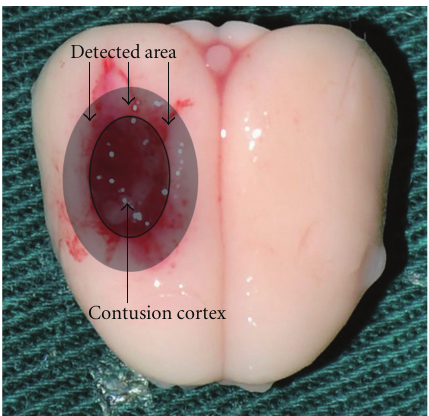
Figure 1: Schematic representation of the contusion cortex induced by weight-dropping trauma and the detected area surrounding the injured brain